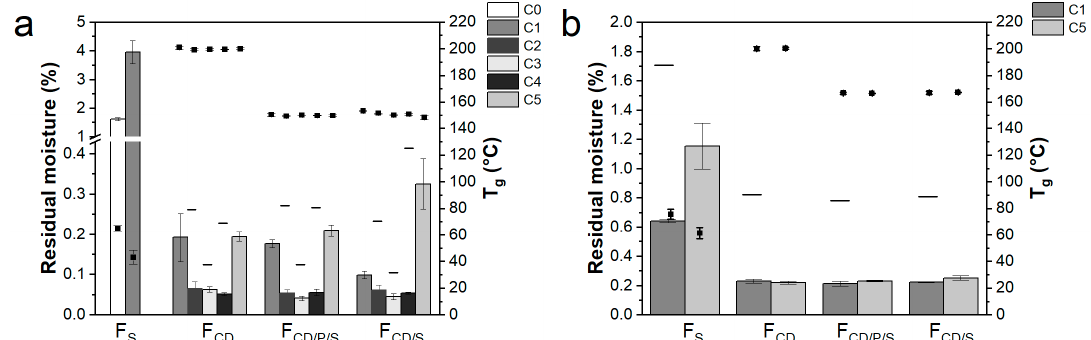
Figure 5. Residual moisture and T g . Data is given for ( a ) 10 mg / mL mAb formulations and ( b ) 50 mg / mL mAb formulations for di ff erent formulations and freeze-drying cycle conditions. Residual moisture levels are shown as bars and lines. Lines show residual moisture level of vials stoppered after primary drying. Squares show T g values of the lyophilisates. Values are means ( n = 3) ± standard deviation.